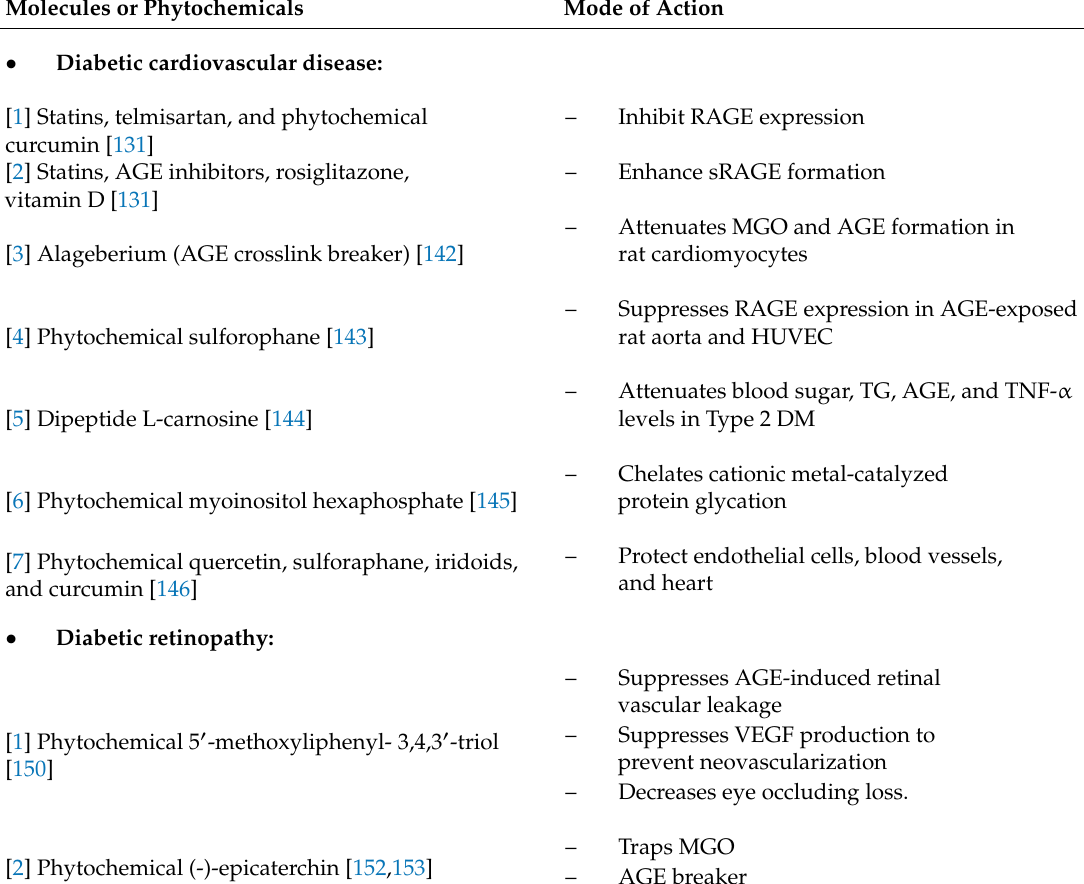
Table 4 lists the chemicals and novel phytochemicals that are e ff ective in the treatment of diabetic cardiovascular complications and retinopathy with their modes of action. Table 4. Novel medicines and phytochemicals acting as new therapeutic strategies in treatment of diabetes-induced cardiovascular disease and